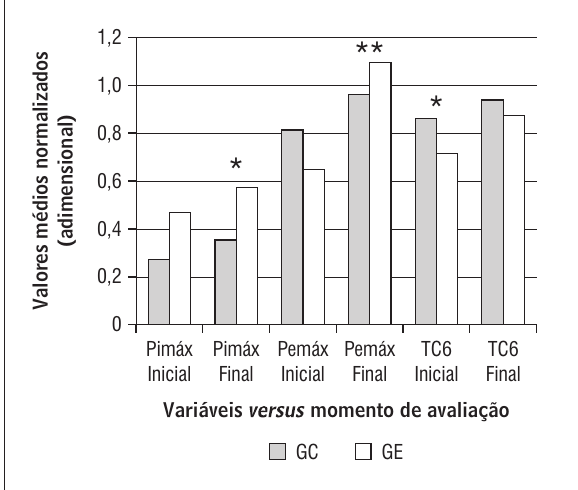
Gráfico 2 - Comparações intergrupo entre as variáveis Pimax, Pemax e TC6 Legenda: Pressão inspiratória máxima = Pimáx; pressão expira- tória máxima = Pemáx; avaliação inicial = I; avaliação fi nal = F; teste de caminhada de seis minutos = TC6; grupo controle = GC; grupo experimental = GE. Os as- teriscos representam os níveis de signi fi cância encon- trados (*p < 0,01; **p < 0,001). Fonte: Dados da Fisioter Mov. 2012